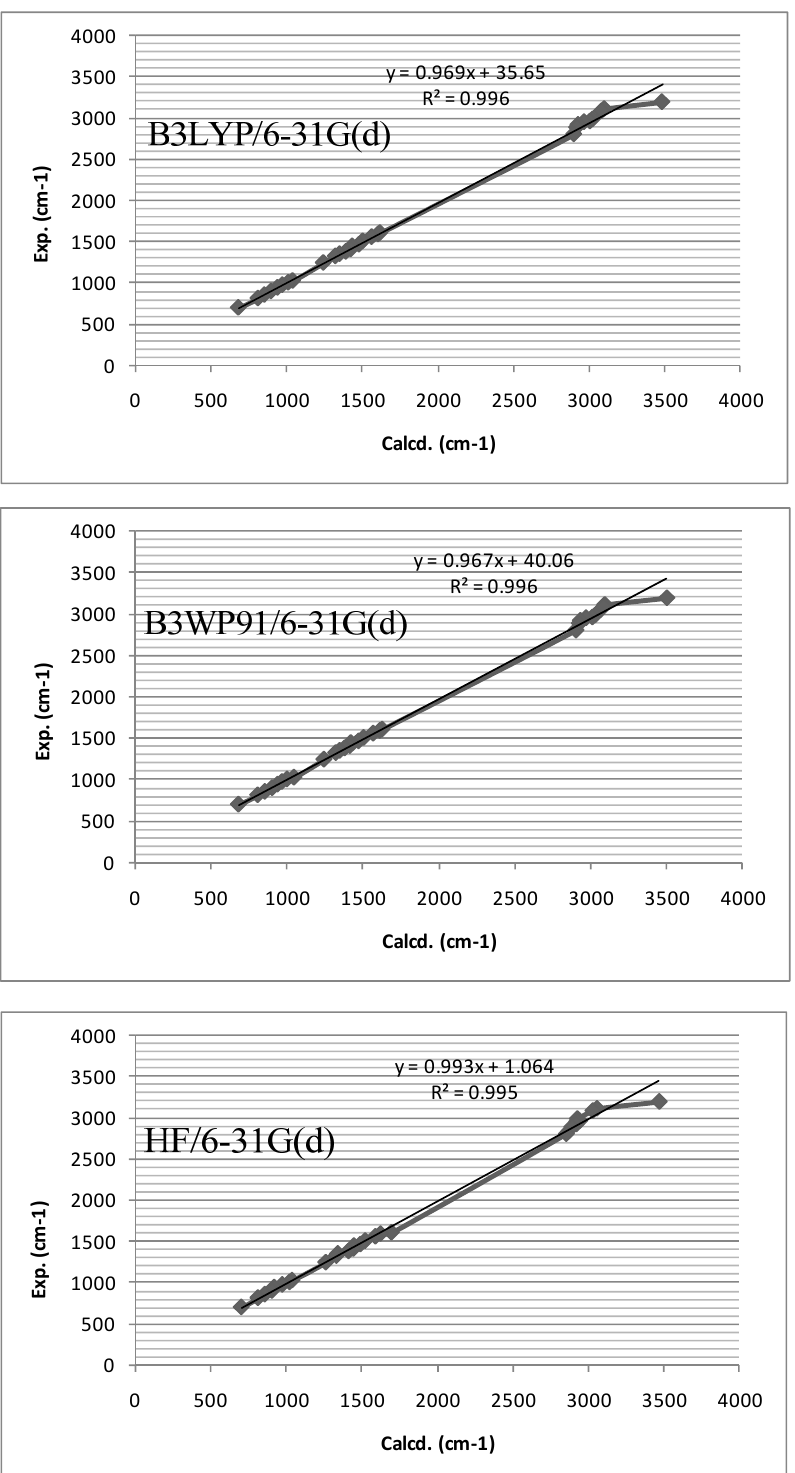
y = 0.993x + 1.064 R² =